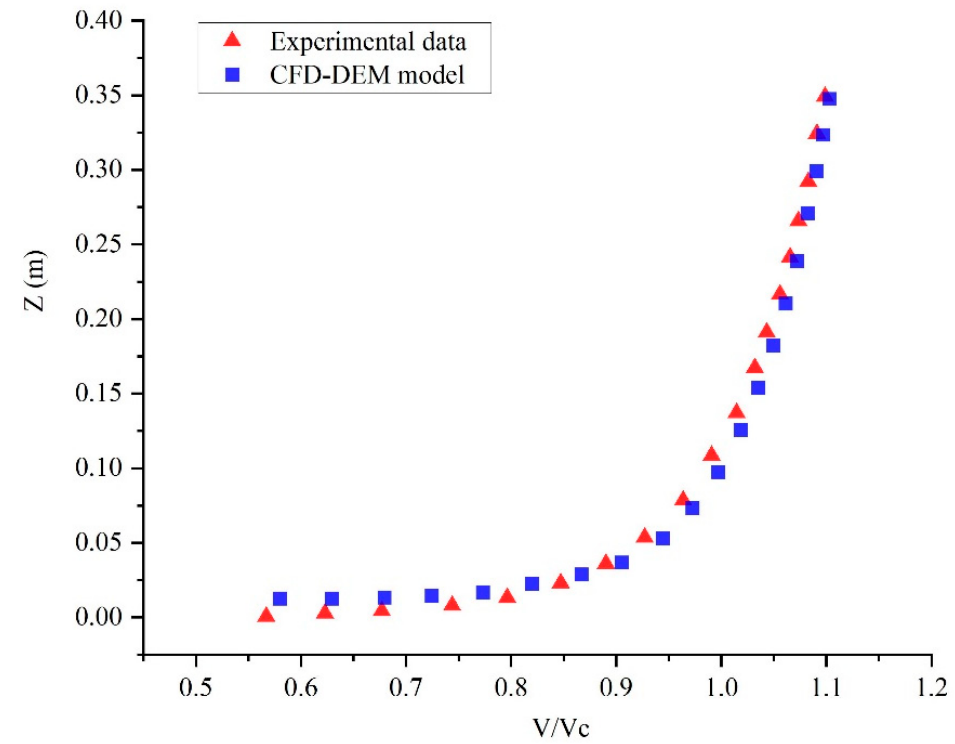
Figure 5. Dimensionless mean velocity distribution. V c represents critical starting flow velocity.